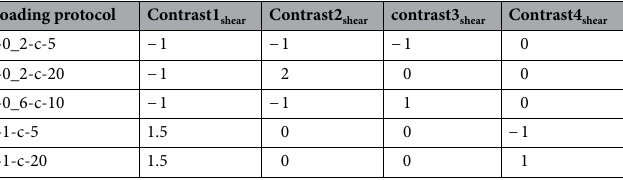
Table 3. Contrasts and their respective weights for the loading protocols—split first according to shear. s shear frequency, c compressive strain.